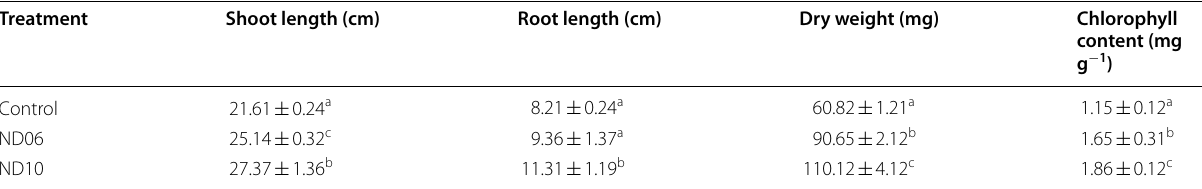
Data represent averages based on 15 seedlings ( n in the column do not differ significantly according to HSD test ( p < 0.05)